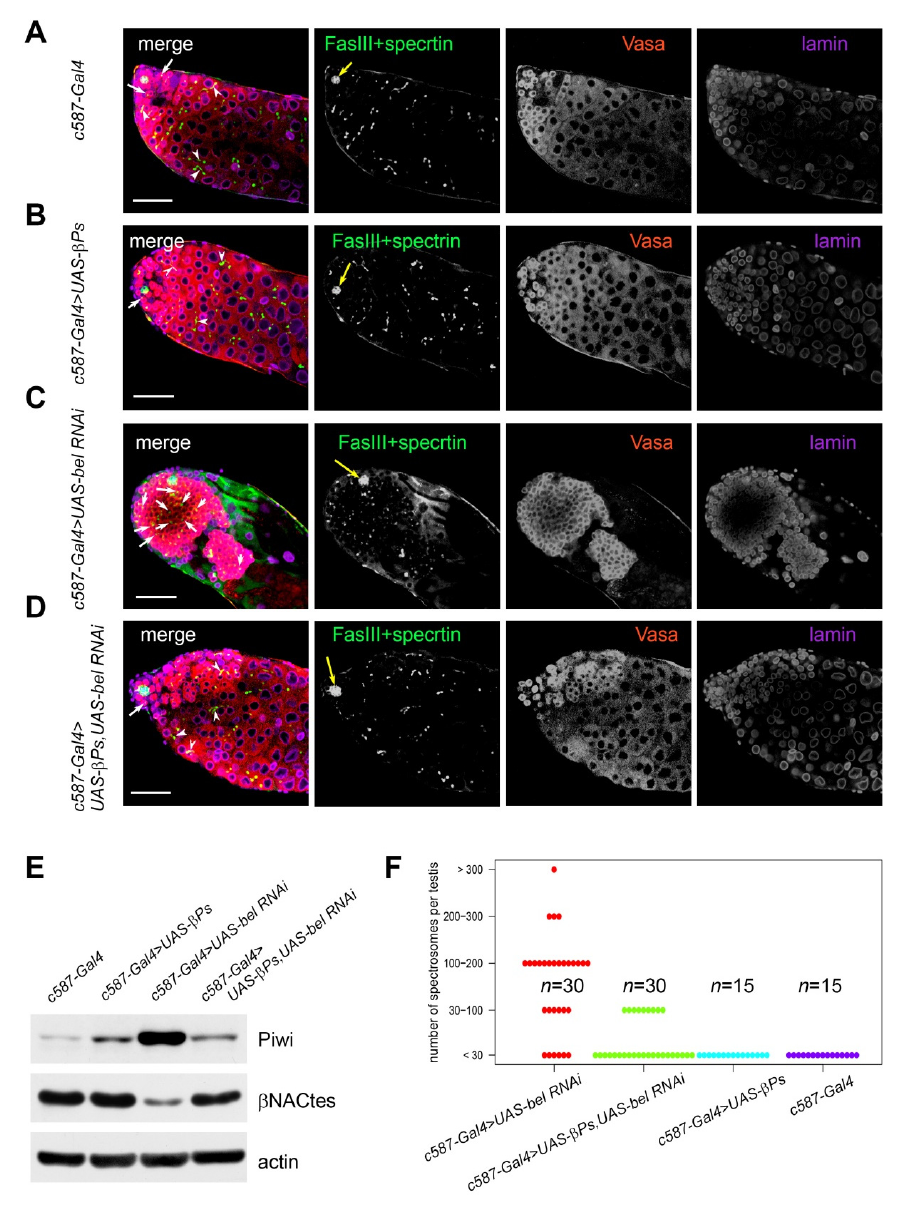
Figure 3. Expression of a transgenic copy of β -integrin in cyst cells rescued early stages of spermatogenesis in the RNAi belKD testes. ( A – D ) Testes of young males were stained with anti-Vasa (red), anti-Fasciclin III (green), anti- α -spectrin (green), and anti-Lamin (violet) antibodies. Yellow arrows indicate hub positions. White arrows indicate spectrosomes, white arrowheads indicates fusomes. Scale bars are 30 µm. ( A ) The testes of c587-GAL4 flies were used as a wild-type control. ( B ) The testes of c587-GAL4 > UAS- β PS flies did not exhibit defects of germ cell di ff erentiation. ( C ) The testes of c587-GAL4 > UAS-bel RNAi males contained clusters of undi ff erentiated early germ cells. ( D ) Ectopic expression of a β PS ( β -integrin) copy in cyst cells in the background of RNAi belKD ( c587-GAL4 > UAS- β PS; UAS-bel RNAi) led to the restoration of premeiotic stages of spermatogenesis. ( E ) Western blot analysis of testis lysates. The marker of germline stem cells Piwi returned to a wild-type level in the testes of c587-GAL4 > UAS- β PS; UAS-bel RNAi males. The marker of spermatocytes β NACtes was restored to its wild-type level in the testes of c587-GAL4 > UAS- β PS; UAS-bel RNAi males. Loading was 45 µ g per lane. Anti-actin antibodies were used as a loading control. ( F ) Counts of spectrosomes in the testes of the experimental and control males. In most of the experimental testes ( belKD + β -int ) the number of spectrosomes did not exceed 30 as in wild-type